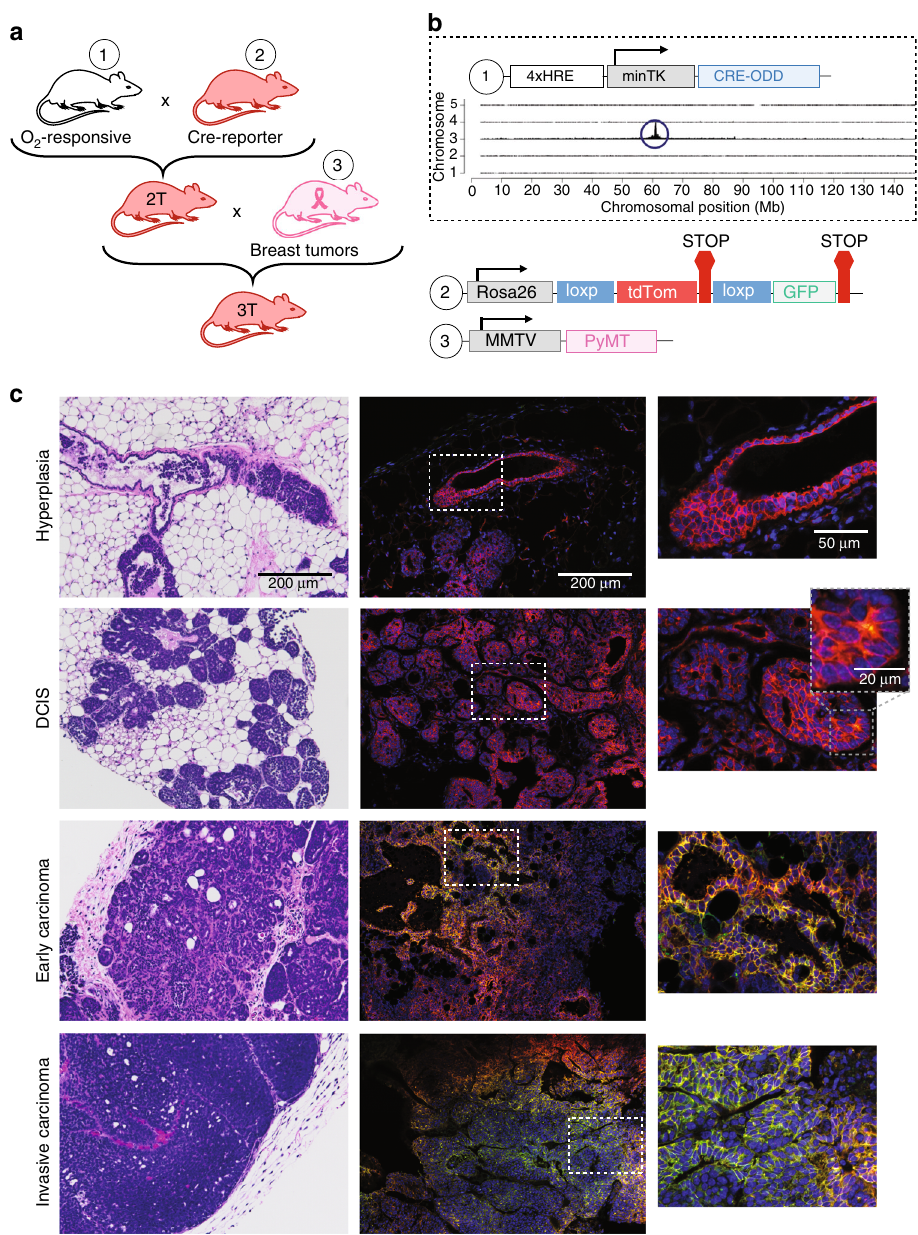
Fig. 2 Establishing a hypoxia fate-mapping triple-transgenic mouse model. a Design of a triple-transgenic mouse generated by (1) developing a transgenic mouse that produces Cre recombinase in cells exposed to hypoxia followed by (2) breeding to the mT/mG reporter mouse (Jackson Labs; 007676). The double-transgenic mouse (2 T) was then crossed to a (3) mouse expressing the MMTV promoter-driven PyMT oncogene that develops spontaneous breast tumors (3 T). b TLA sequence coverage across the mouse genome by using primer sets 1 and 2 (Supplementary Table 2) was conducted to determine the location of our transgene. The 4xHRE-CRE-ODD transgene integrated at chromosome 3 position 61,062,240. c Triple-transgenic mice were sacri fi ced at different time points over a 4-month period in order to detect hypoxic cells during breast cancer progression from hyperplasia, to ductal carcinoma in situ (DCIS), to early carcinoma and invasive late-stage carcinoma. H&E-stained sections of paraf fi n-embedded tissue (left) or fl uorescent imaging of frozen tissue sections (right). Marked insets are displayed on the right. The second inset at the DCIS stage highlights early detection of